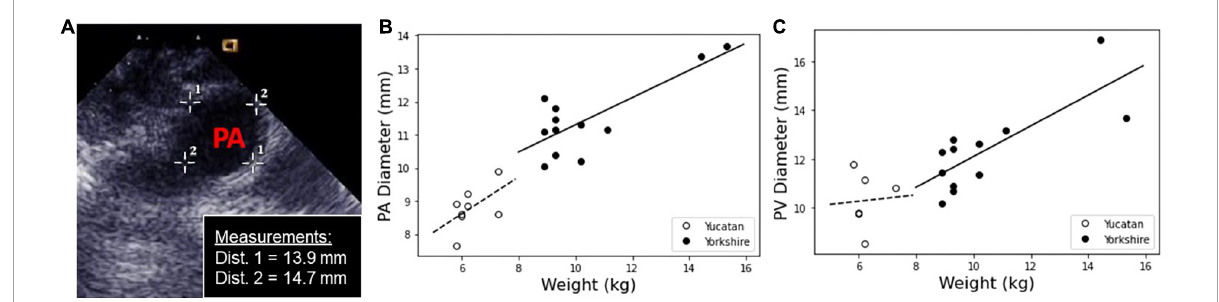
FIGURE2 Measurements of PA and PV diameters were taken in situ using echocardiogram, and calculated ex vivo from the tissue sample circumference. (A) The in vivo measurements of the PA and PV were measured using a cross-sectional image within the echocardiogram software. A representative image is shown with PA diameter measurements. (B) PA and (C) PV diameter measurements for Yucatan (YU) and Yorkshire (YO) populations as a function of weight.